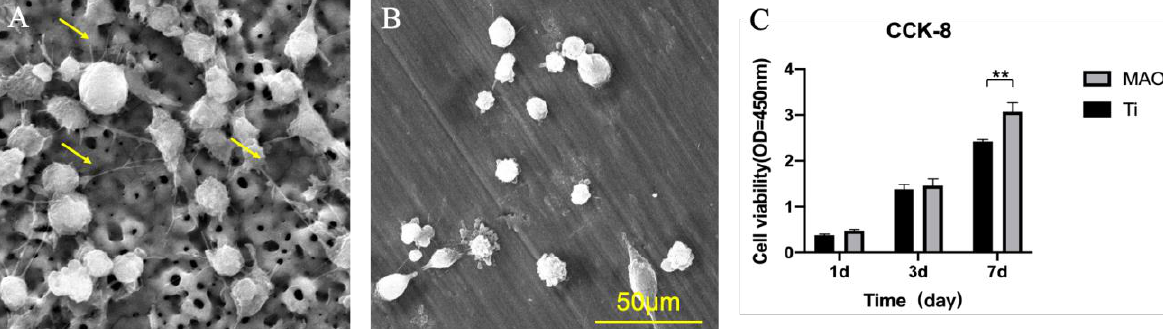
Figure 2. The growth pattern and morphology of Schwann cells on MAO ( A ) and Ti ( B ) surfaces, and the result of CCK-8 ( C ). (“**” means p < 0.01).